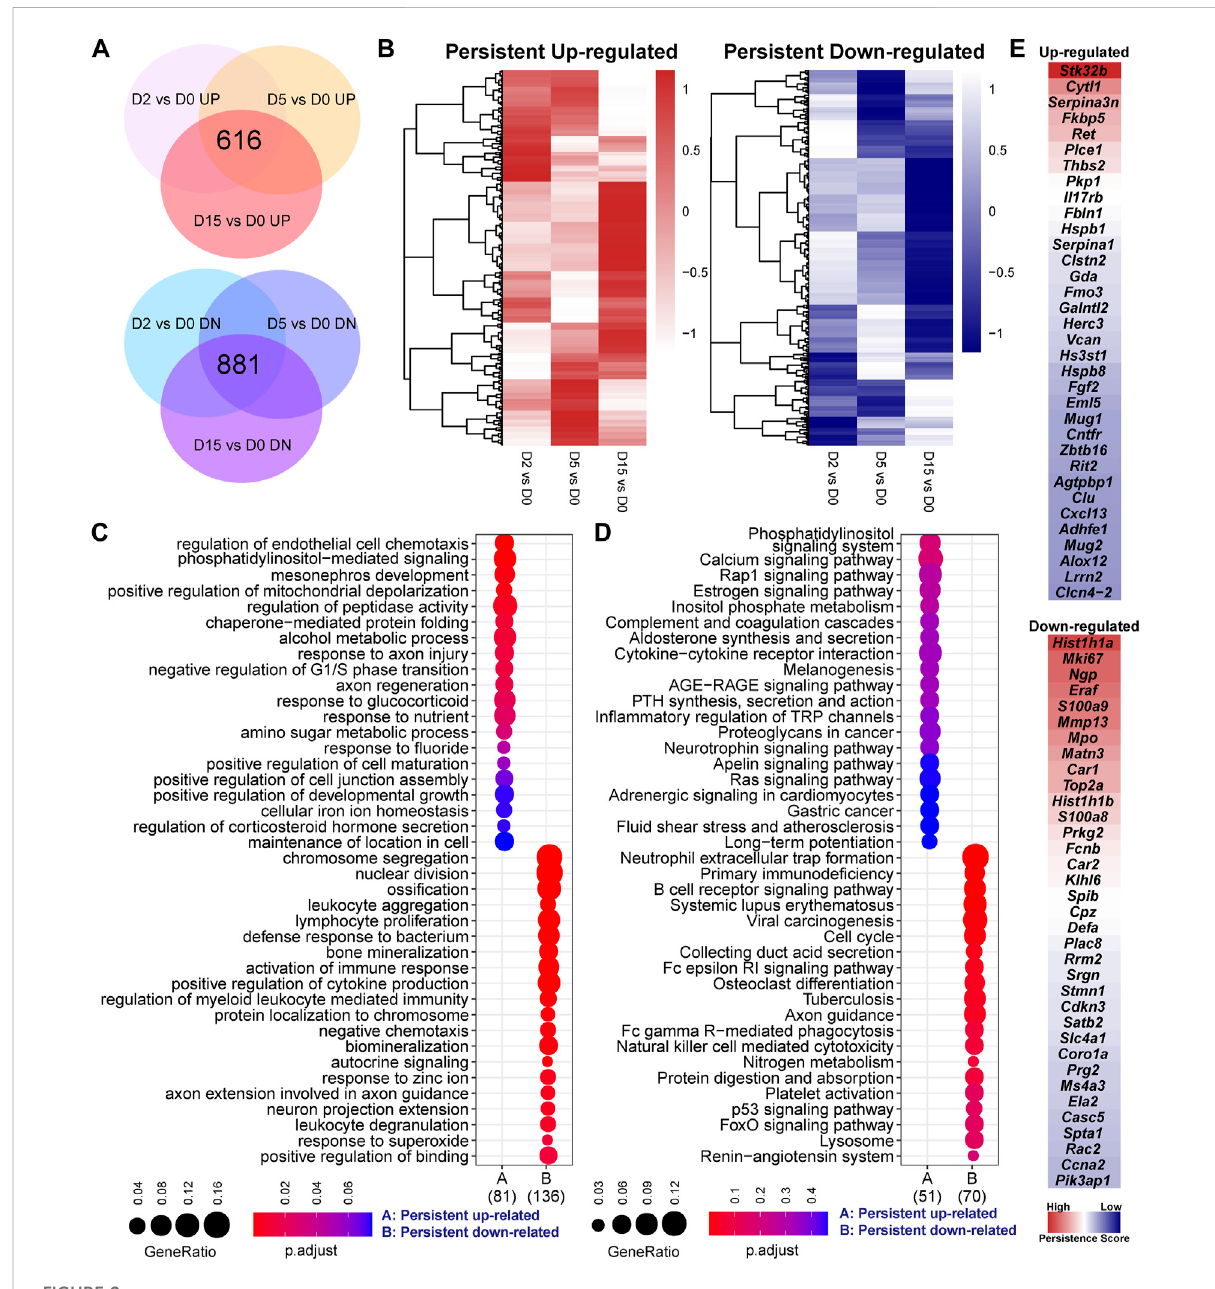
FIGURE 2 Persistent responsive genes are related to cell division, in fl ammation, and metabolism. (A) Overlapped genes of three set of differentially expressed genes of serial comparisons, including 616 persistent upregulated and 881 persistent downregulated genes. (B) Heatmaps of the fold- changevaluesoftwoclustersofpersistentgenes.Theheatmappatternsshowthatsomegenesexhibitatime-relatedchangeofgeneexpression. (C) GO analysis and (D) KEGG pathway analysis of persistent genes. GeneRatio indicates the gene number ration in each GO function and KEGG pathway.Thecolorandsizeofdotrepresent p -valueadjustedbyBenjaminiandHochbergmethodandgenenumberassigned tothecorresponding GO function and KEGG pathway, respectively. (E) The top 35 up-regulated or downregulated genes based on persistence score. A high persistence score indicates a stable response in the exercise